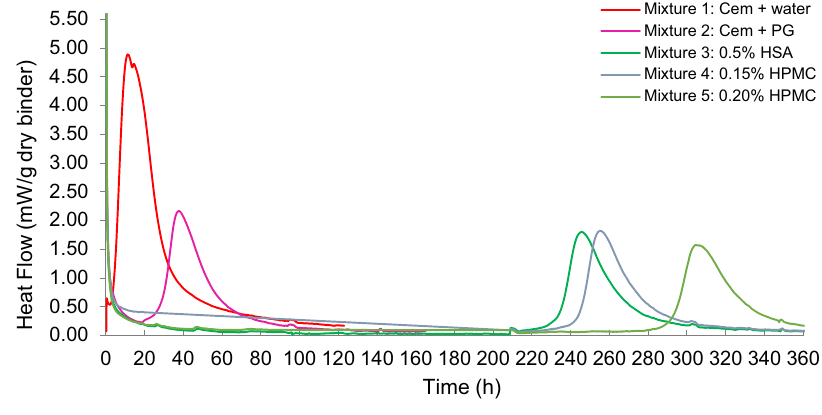
Figure 2: Heat fl ow for 360